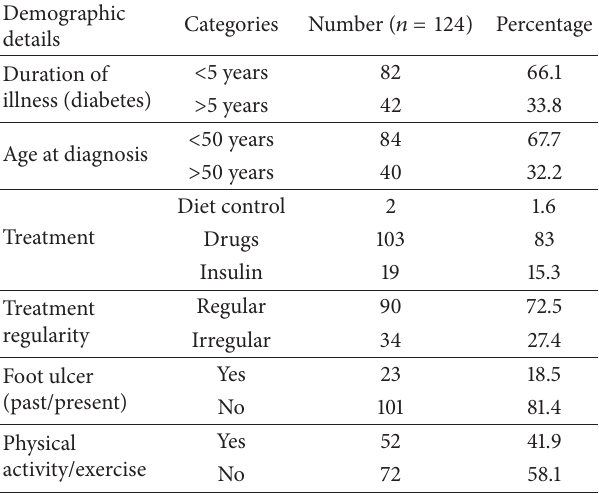
Table 2: Details of disease and treatment among study